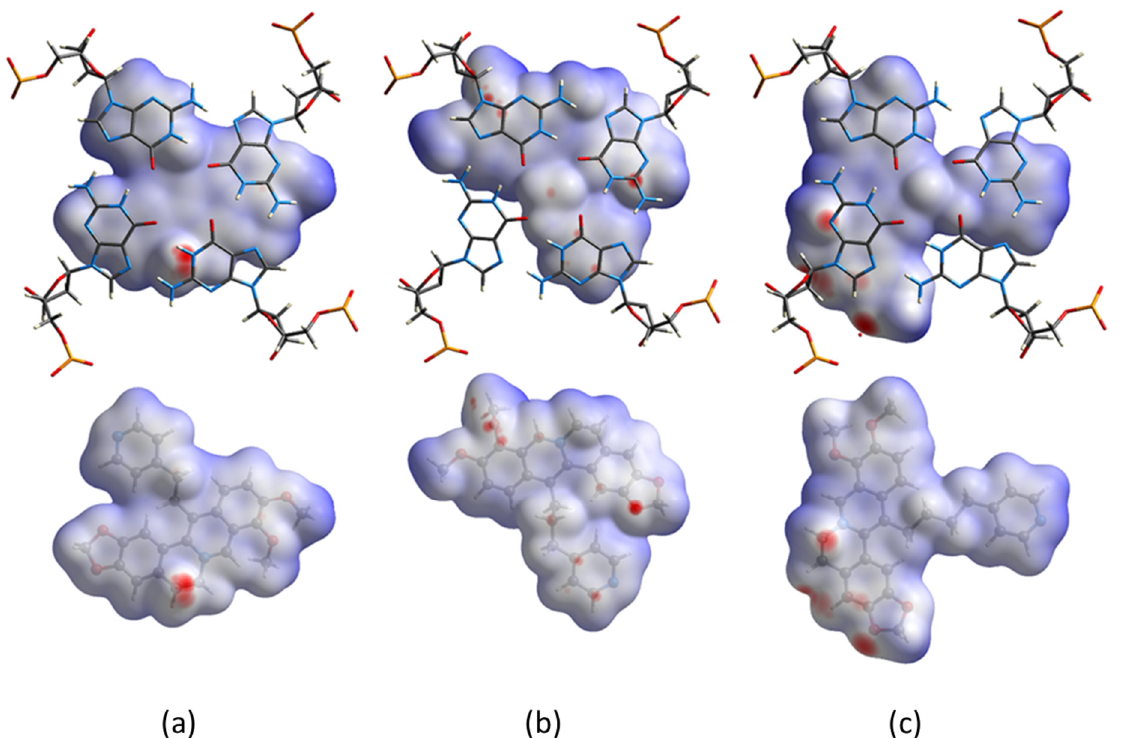
Figure 5. Results of the Hirshfeld surface’s analysis for the ligand/Tel12 crystal structures: 2 ( a ); 3 ( b ) and 4 ( c ) (lower panel) in contact with the 3 ′‐ end GGGG tetrad (upper panel). Red spots mark the shortest contacts.